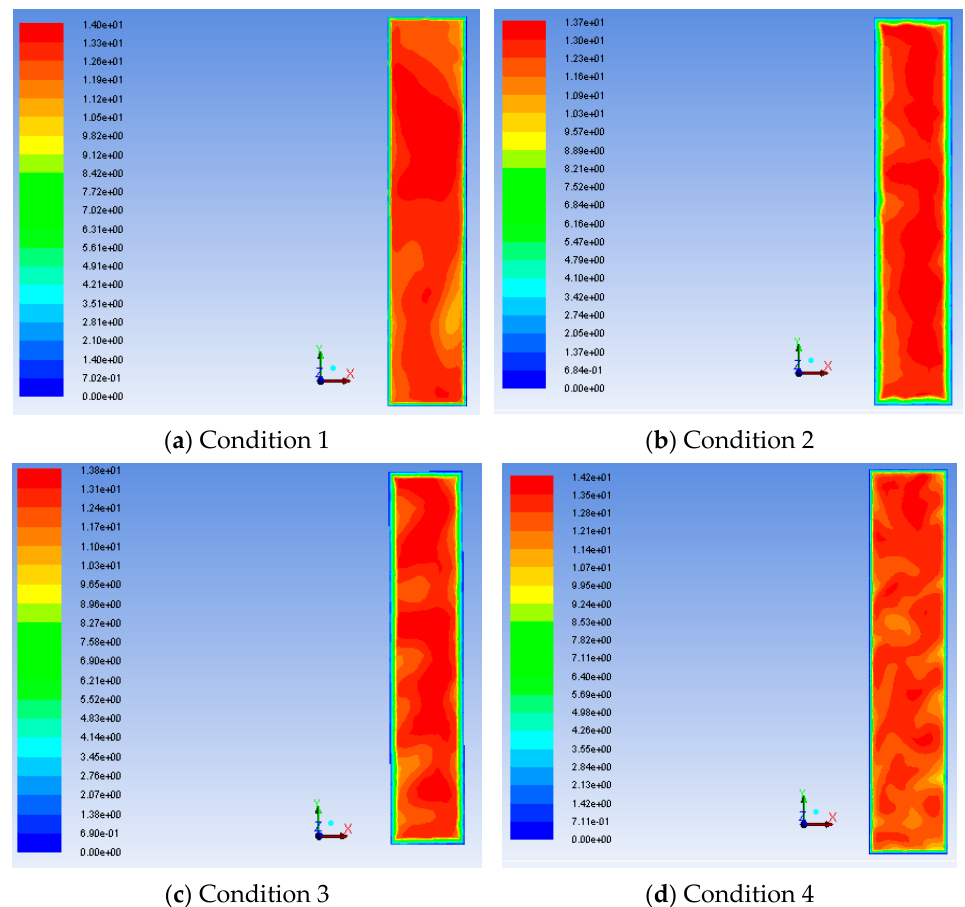
Figure 5. AIG downstream cross-section velocity distribution, m/s. ( a ) Condition 1; ( b ) Condition 2; ( c ) Condition 3; ( d ) Condition 4.